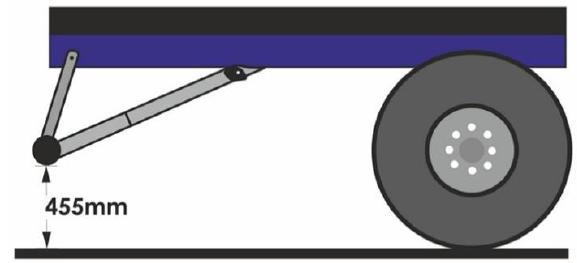
Figure 10. RUPD provided with a tubular energy absorber.